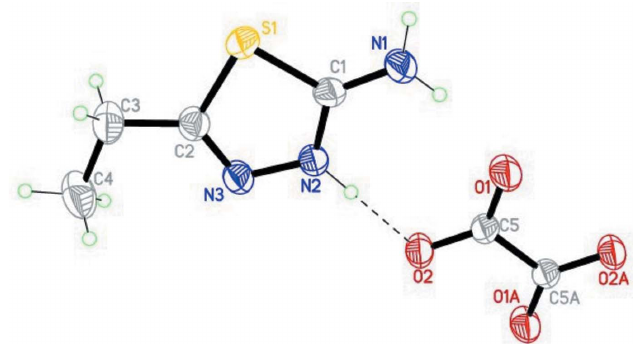
Figure 1 The molecular structure of compound (I), with the atom labeling and displacement ellipsoids drawn at the 40% probability level. The dashed line represents the intramolecular hydrogen bond. Symmetry code: (A) 2 (cid:3) x , 1 (cid:3) y , 1 (cid:3) z .